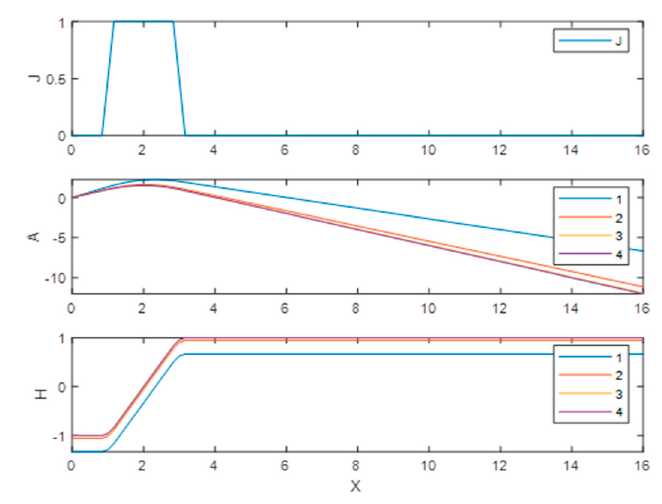
Figure 4. Influence of the ferromagnetic walls’ magnetic permeability on the magnetic potential and the magnetic field in the air window. Table 1. Actual values of magnetic potential at x = 0.